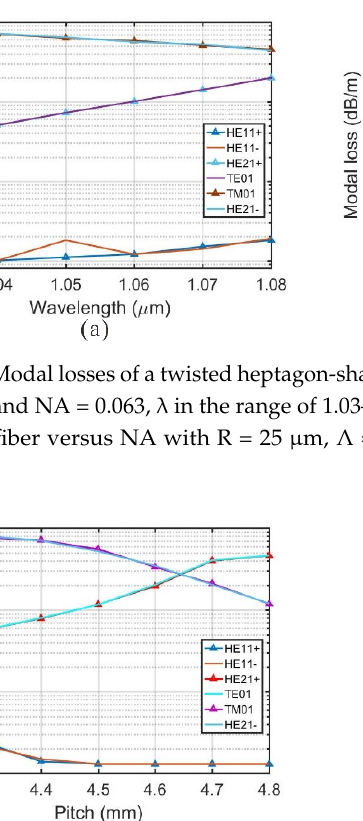
Figure 10. ( a ) Modal losses of FM in a twisted octagon-shaped core fiber versus Λ and NA with R = 40 μm, λ = 1064 nm, NA in the range of 0.068–0.072, and Λ in the range of 3.7–4.1 mm. ( b ) Ratios of the lower one of first HOM losses to fundamental mode losses.